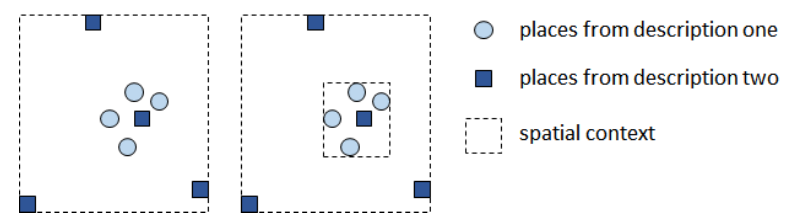
Figure 8. The spatial context of a merged, original place graph ( left ), and separated spatial contexts of an extended place graph ( right ).